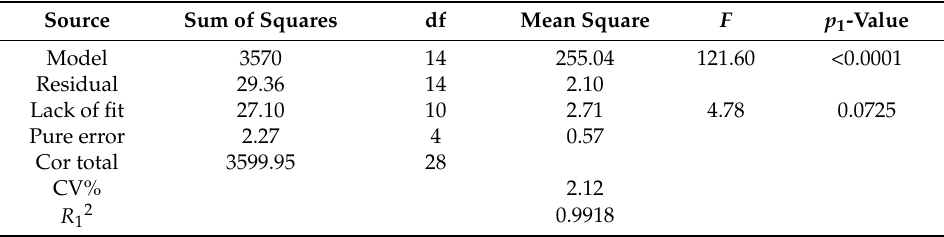
Table 3. The variance analysis of the fitted quadratic polynomial prediction model of Y. Source Sum of